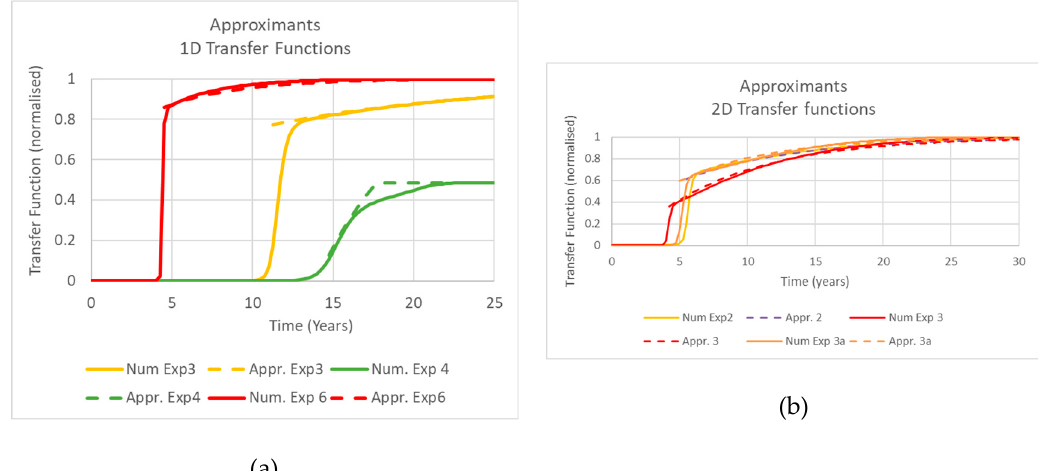
Figure 7. Approximants against numerical solutions for which perching occurs. Solid lines represent numerical solutions and dashed lines approximants. ( a ) 1D modelling experiments 3, 4 and 6. The approximants are respectively: 1 − exp( − 0.07 × ( t + 10)), t < 12; 4: min(0.486,1 − exp( − 0.18 × ( t − 14))), t > 15; and 6: 1 − exp( − 0.22 × ( t + 4.4)), t > 5. ( b ) 2D Modelling Experiments 2, 3 and 3a. The approximants are respectively: 2: 1 − exp( − 0.12 × ( t + 2.5)), t > 6; 3: 1 − exp( − 0.13 × ( t − 0.8)), t > 4; and 3a:1 − exp( − 0.15 × ( t + 1)), t > 5.